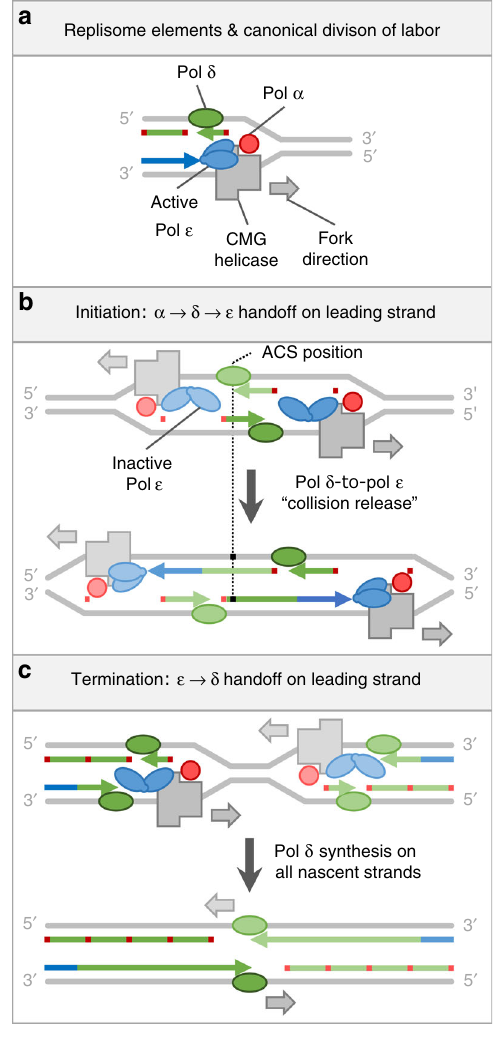
Fig. 1 Models of canonical polymerase division of labor and exceptions at replication origins and termination zones. a Replisome components and canonical polymerase division of labor. Red, green, and blue denote Polymerases α , δ , and ε , respectively, or the nascent DNA tracts they synthesize. DNA strands (colored bars) and proteins are not shown to scale. Other replisome components are omitted for simplicity. b A model of replication initiation. Replication initiates with Pol α priming on both strands. On the lagging strand, priming is repeated with Pol α passing the 3 ′ terminus to Pol δ for Okazaki fragment synthesis. On the leading strand, Pol α passes the 3 ′ terminus to Pol δ , which then catches the receding helicase complex and passes the 3 ′ terminus to Pol ε . c A model of replication termination wherein Pol ε disengages from the 3 ′ terminus and Pol δ assumes responsibility for the remainder of leading strand